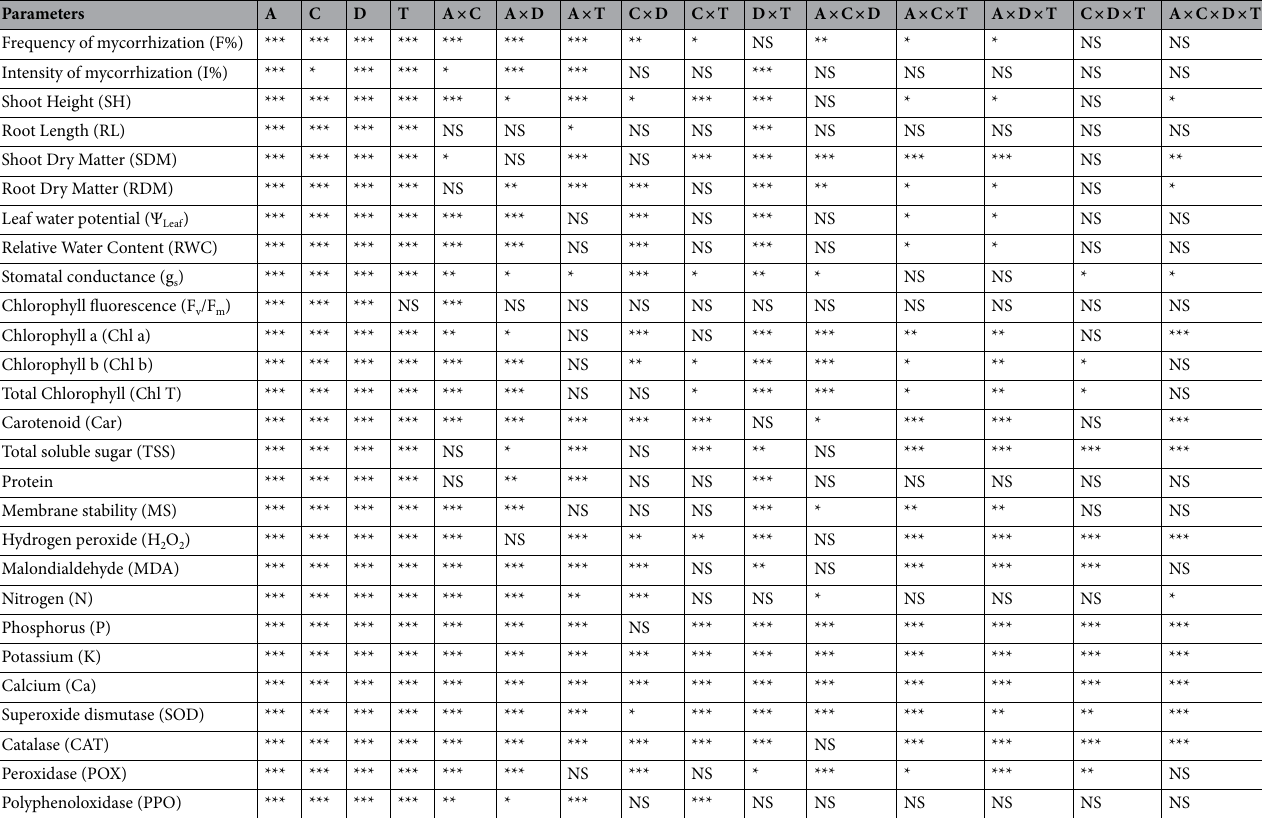
Table 1. ANOVA test results for independent variables; (A) AMF, (C) compost, (D) drought, and (T) timing of the measured parameters in carob. NS, not significant, * P < 0.05, ** P < 0.01, *** P <